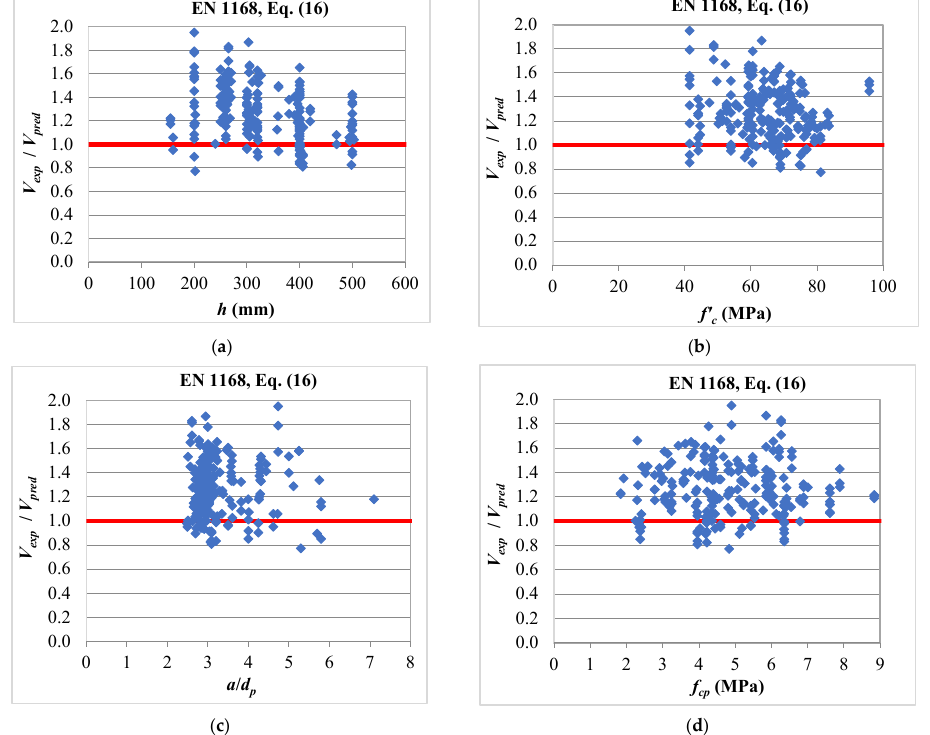
Figure 8. Predictions of the EN 1168 design equation against ( a ) total thickness, ( b ) concrete com- pressive strength, ( c ) shear span to depth ratio, and ( d ) compressive stress due to the fully effective prestressing force.